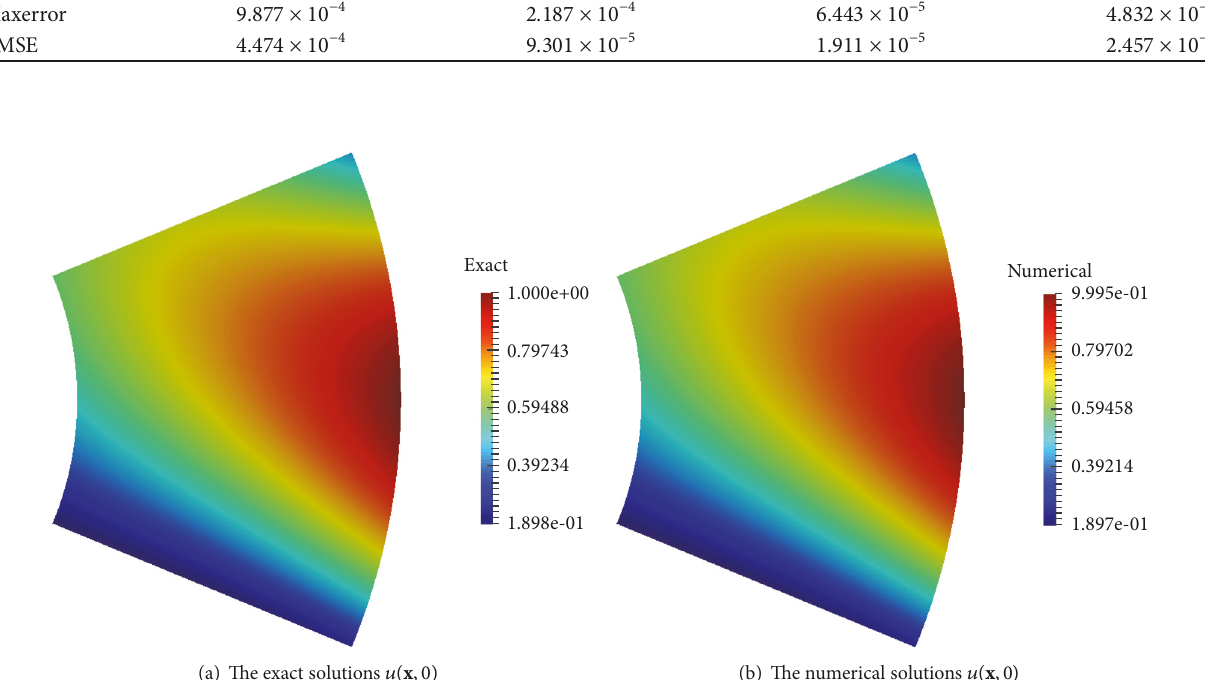
Figure 7: The figure with 𝑎 = 0.5 , 𝑏 = 1.0 , 𝑐 = −0.5 , 𝑑 = 0.5 , and 𝜃 = 𝜋/4 .